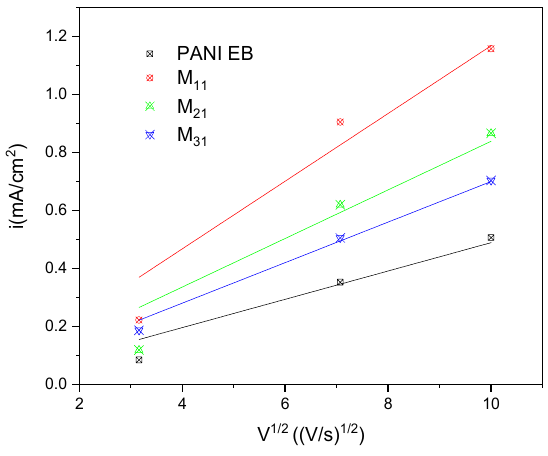
Figure 9. Peak current variation with scan rates.